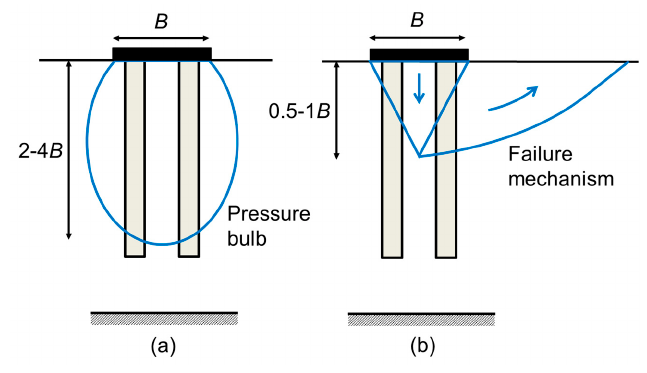
Figure 16. Conceptual justification of critical column length in a homogenous soil layer: ( a ) for settlement reduction; ( b ) for bearing capacity.